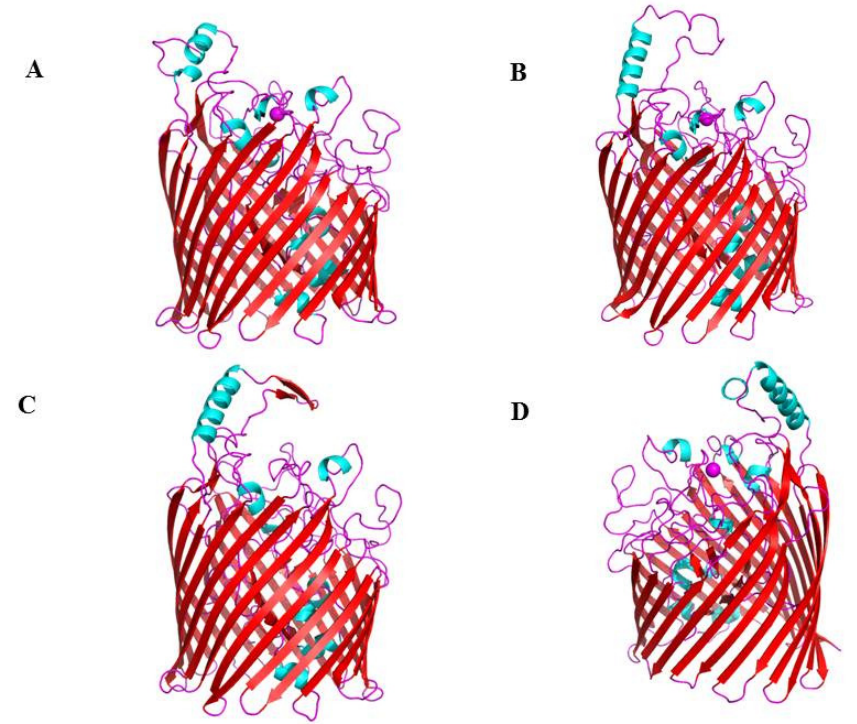
Figure 1. Predicted 3D protein models. ( A ) CAM07737. ( B ) CBA03648. ( C ) CBA07476. ( D ) CBA09441 (FrpB). The ball structure (magenta color) represents the Fe +3 ligand molecule. Table 5. Model evaluation scores and energy of the model of before and after energy minimization. Accession